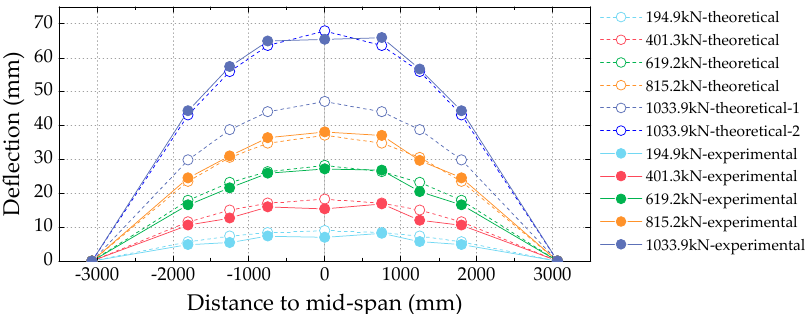
Figure 14. Comparison of analytical value and test results of specimen deflection in different load.